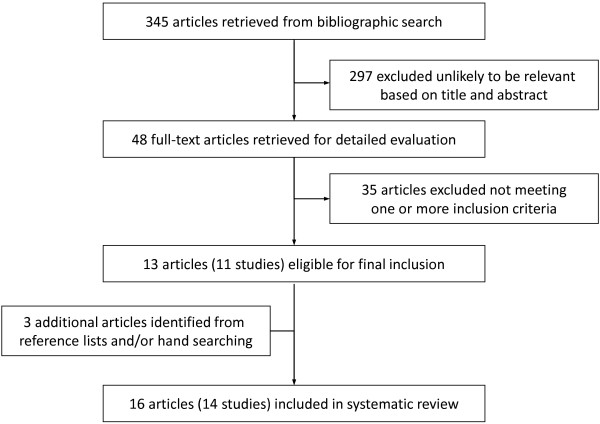
Flow diagram showing selection process of articles included in the systematic review.